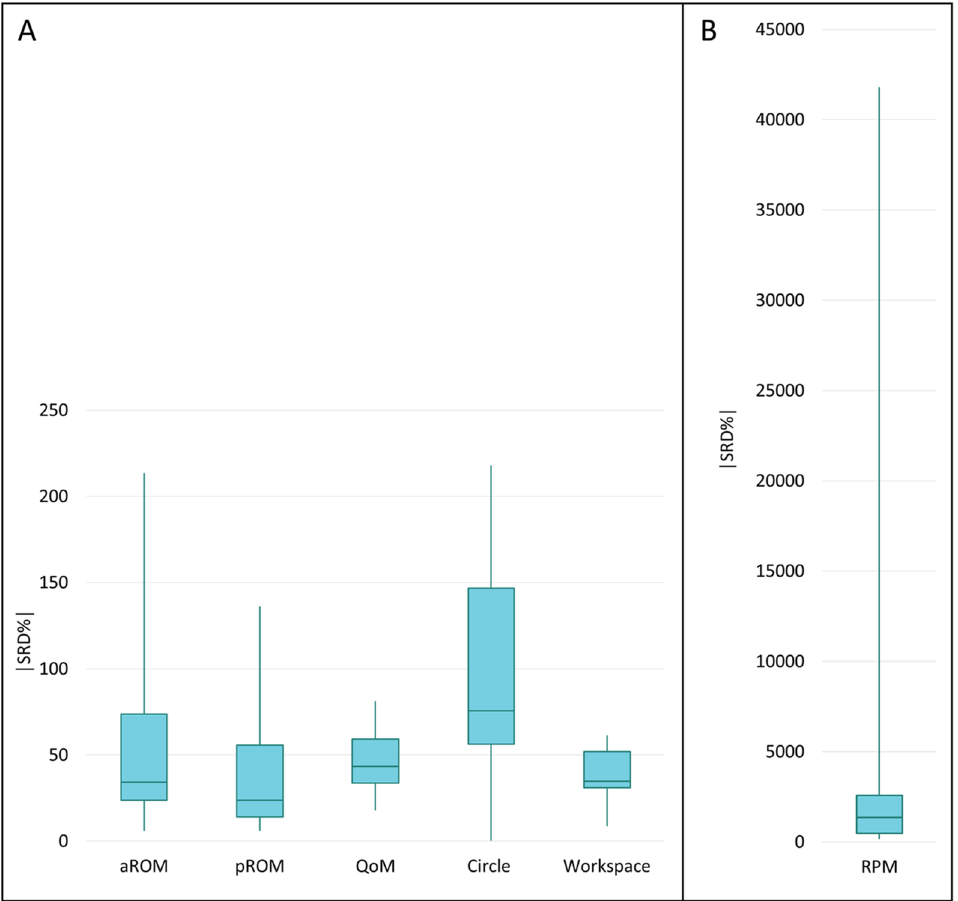
Figure 4. Measurement errors. The box-plots represent the distribution of the smallest real differences as a ratio of the grand means of all the parameters of each assessment. ( A ) Active Range of Motion (aROM), passive Range of Motion (pROM), Strength, Quality of Movement (QoM), Circle, and Workspace assessments. ( B ) Resistance against passive movement